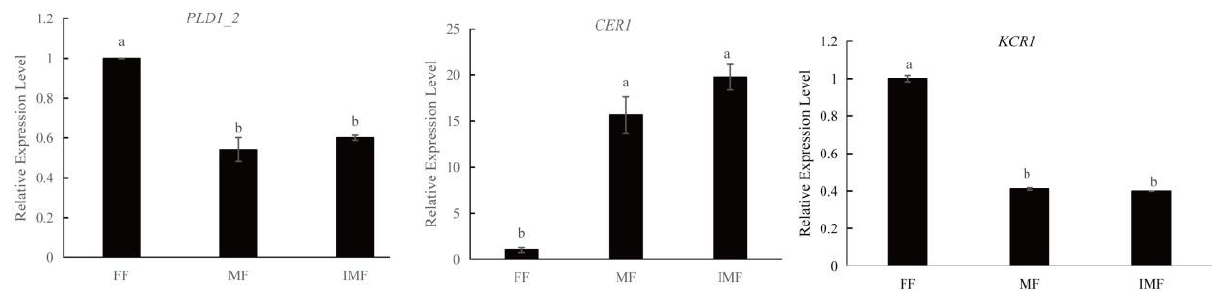
Figure 9. The gene expression level of three genes ( PLD1_2 , CER1 , KCR1 ) of lipid metabolism path- way by qRT-PCR. Different letters indicate significant differences among three tissues according to one-way ANOVA test ( p < 0.05). FF: female flower; MF: male flower; IMF: induced-male flower.